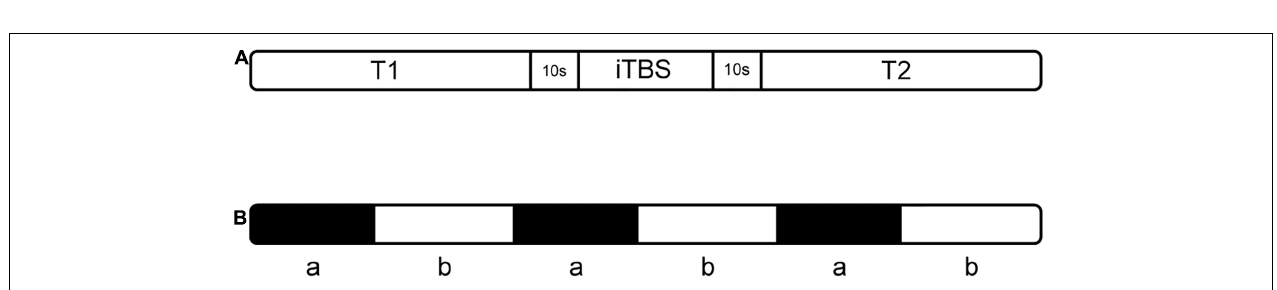
FIGURE 2 | Placement of optode. (A) Optode set arrangement with numbers displayed on a three-dimensional model of the brain (ICBM 152 Non-linear Atlases, version 2009). (B) Two-dimensional distribution of the light source and detection point. (C) Cerebral cortex where channels are covered.